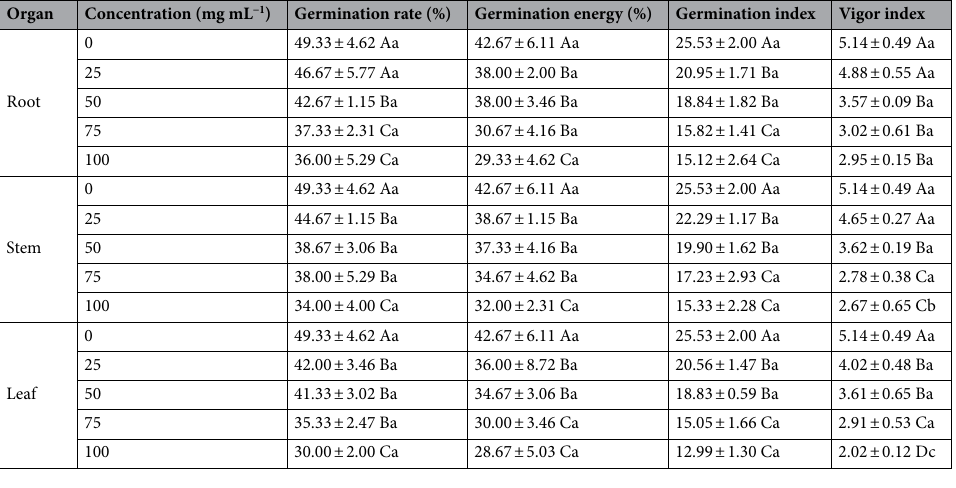
Table 1. Effects of different aqueous extracts of sesame on the germination indices. Different capital letters of the same organ in the same column indicated significant differences among different concentrations at P < 0.05 level, and different lowercase letters of the same concentrations in the same column indicated significant differences among different organs at P < 0.05